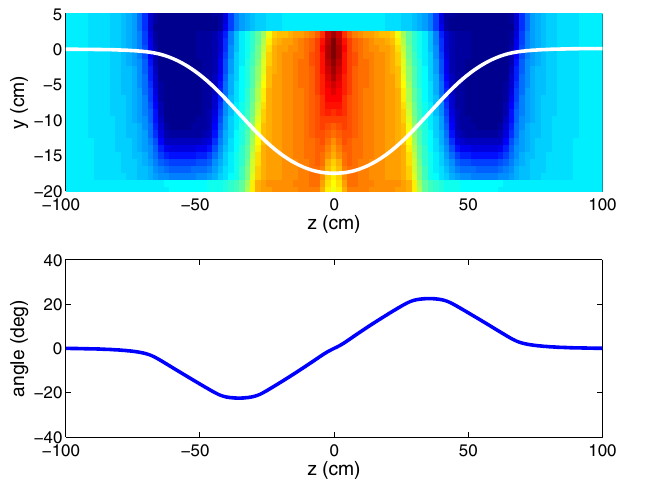
FIG. 7. (Color) Example of energy distribution of the two- FIG. 6. (Color) Overview of the magnetic bunch-compressor macroparticle bunch. The top figure is the beam transverse chicane. Top: electron vertical trajectory superimposed to a false (cid:7) x (cid:2) 0 ; y; z (cid:8) ; bottom: electron density recorded on a screen downstream of the spectrometer color map of the magnetic field B x vertical deflection angle. The electron energy is 12.9 MeV, and (horizontal axis is dispersive axis) and the bottom plot is the the maximum B-field of the dipoles are 593.20 and (cid:1) 592 : 35 G corresponding fractional momentum distribution. The bunch for, respectively, the outer and inner mean energy is E (cid:2) 12 : 9 MeV for the data presented.